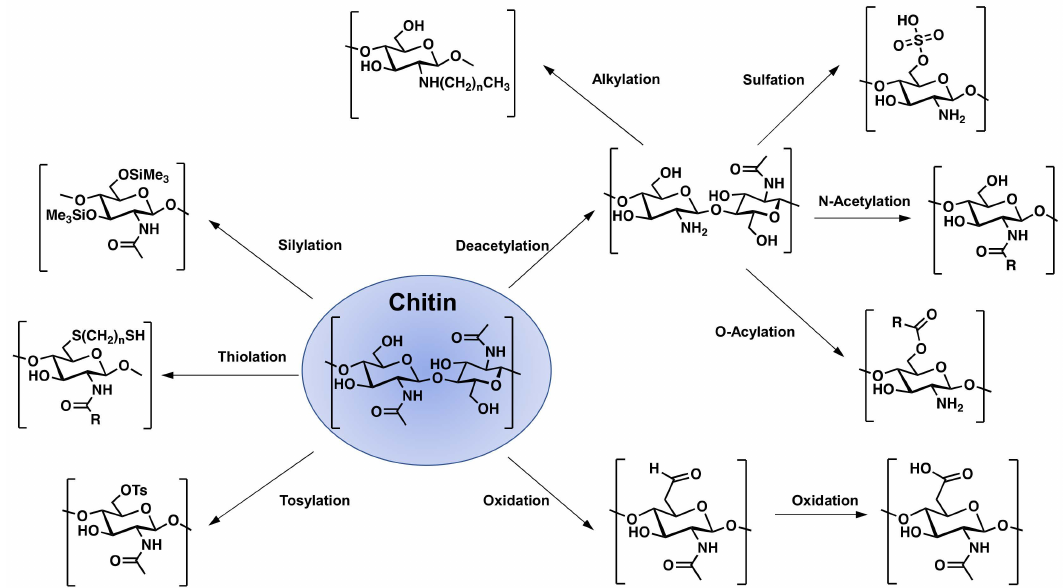
Figure 4. Schematic representation of some of the most used chemical modification reactions of chitin